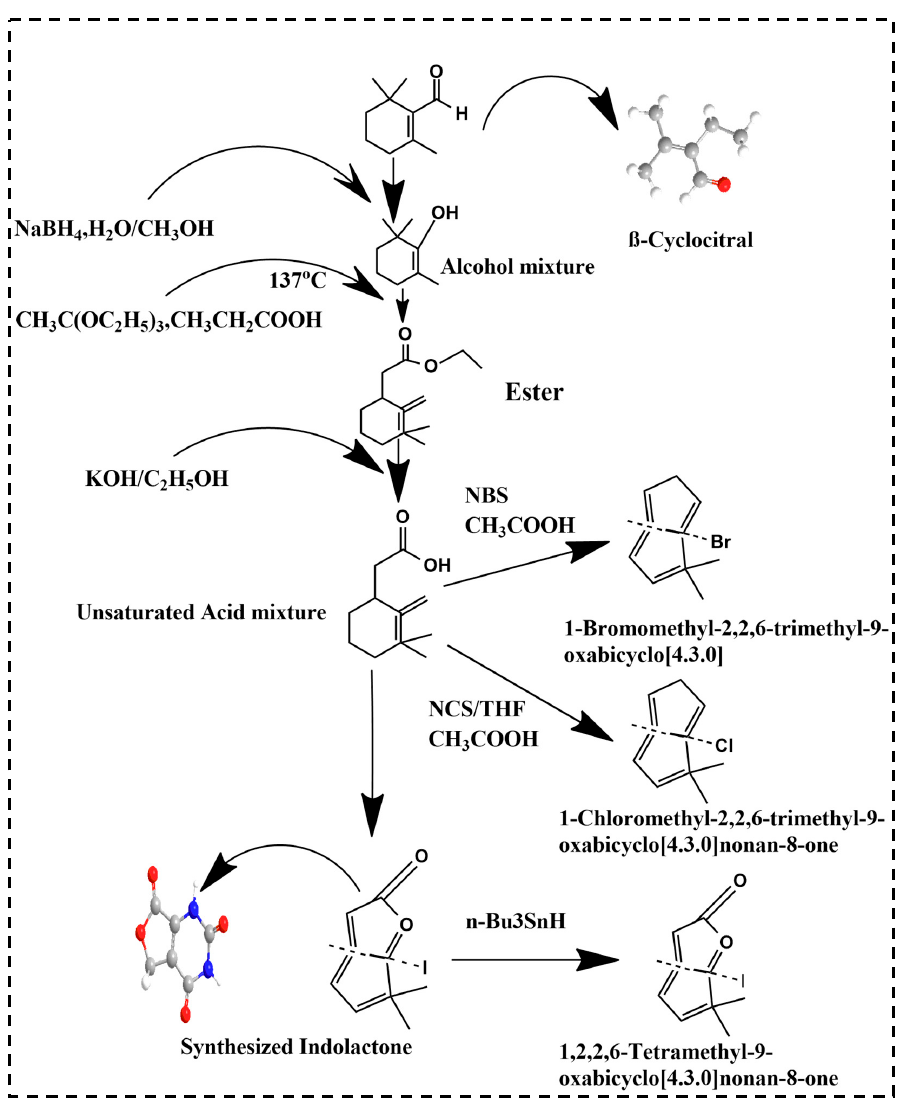
Figure 1. Lactone synthesis from β CC. In the leaves of Arabidopsis , the oxidation of β CC results in β -cyclocitric acid (2,2,6-trimethyl cyclohexene-1-carboxylic acid) which is responsible for the accumulation under strain conditions [31]. The level of β -cyclocitric acid in plants under drought stress increased by an aspect of 15 and doubled the content of β CC only. An accumulation of β -cyclocitric acid in plants exposed to volatile β CC was observed [31]. In the leaves and fruits of tomato, the levels of β -cyclocitric acid are remarkably more than that of β CC. Unlike in water, the conversion of β CC to β -cyclocitric acid was much faster in plants, suggesting the role of enzymatic catalysis [47]. As it remains undiscovered, there might be a connection of a Baeyer-Villiger monooxygenases that yields esters from carboxylic acids and ketones from aldehydes [48]. In brassinosteroid biosynthesis, this type of en- zyme responsible for the oxidation of castasterone to brassinolide has been reported [49]. A regulatory mechanism that modulates the β CC-mediated signaling could be repre- sented by the process of glycosylation of β CC. However, from the total β CC pool, gly- cosylated β CC was found to represent only a small portion (<2%) [30]. The β CC converts